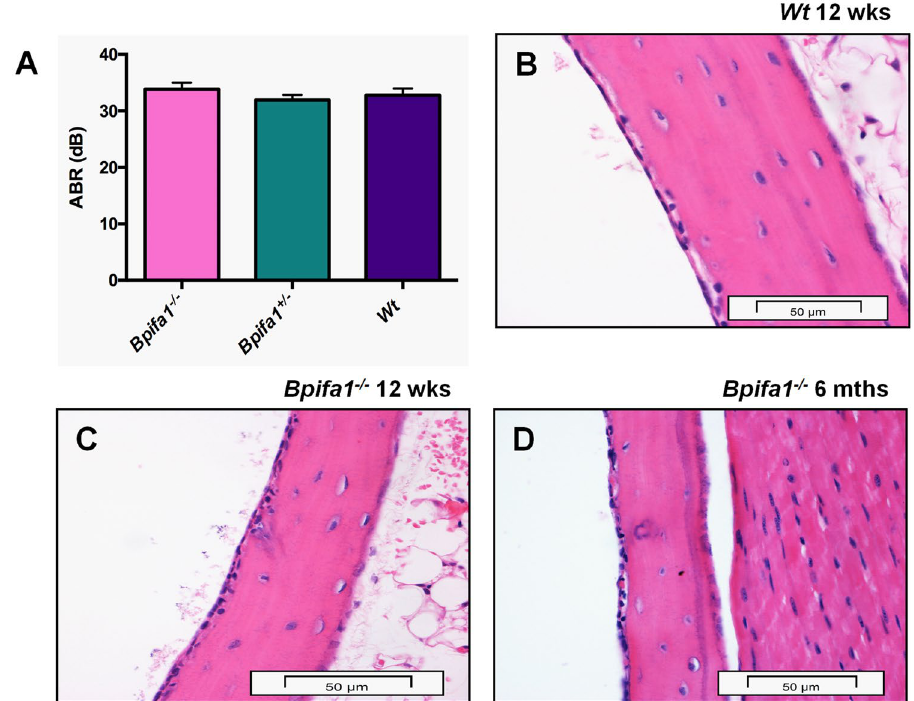
Figure 2. Loss of the BPIFA1 is not associated with hearing deficits or development of OM. Auditory brain stem thresholds for Bpifa1 − / − (n = 13) and Bpifa1 + / − (n = 18) mice do not differ significantly from those of WT mice (n = 9) at 12 weeks of age ( A ). p > 0.05 for One-way ANOVA with Tukey’s posthoc test. Representative High power images of H&E sections of the ME of n = 8 WT ( B ), and Bpifa1 − / − ( C ) at 12 weeks age and n = 13 Bpifa1 − / − ( D ) mice at 6 months of age show no histological abnormalities. Scale bar 50 μ m for 60x objective